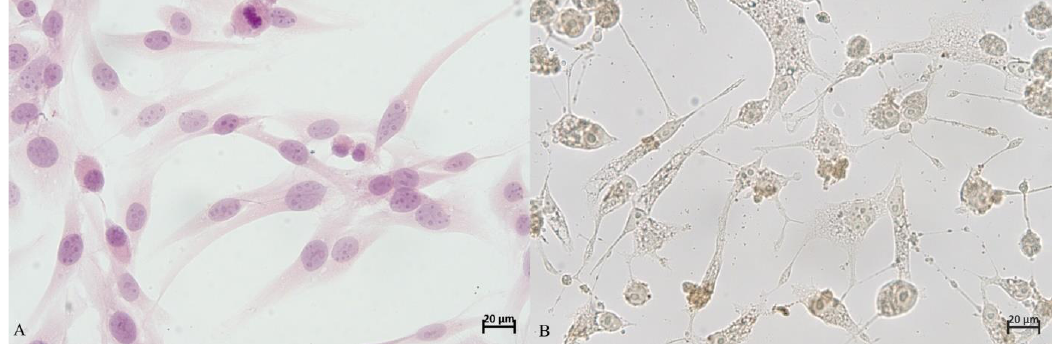
Figure 1. The comparison of microscopic picture of non-apoptotic ( A ) and apoptotic ( B ) cell cultures used in this study (D-17), 40×.